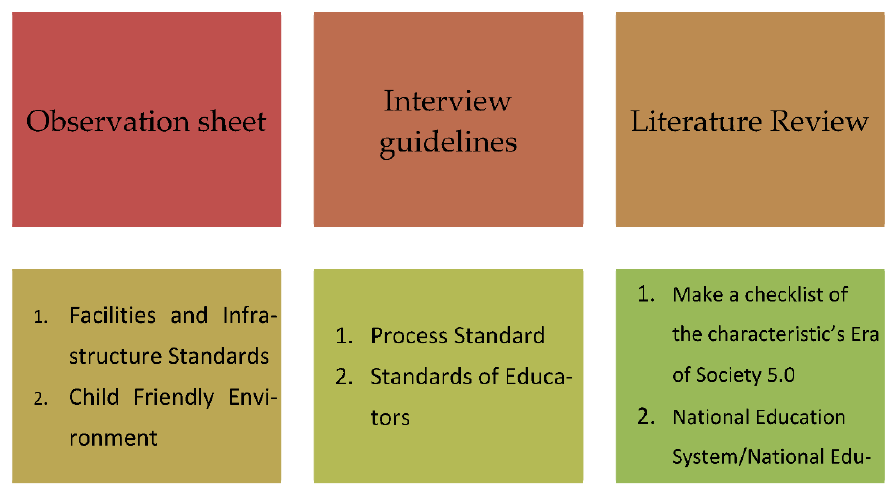
Figure 1. Content Data Analysis Techniques (Content Analysis).